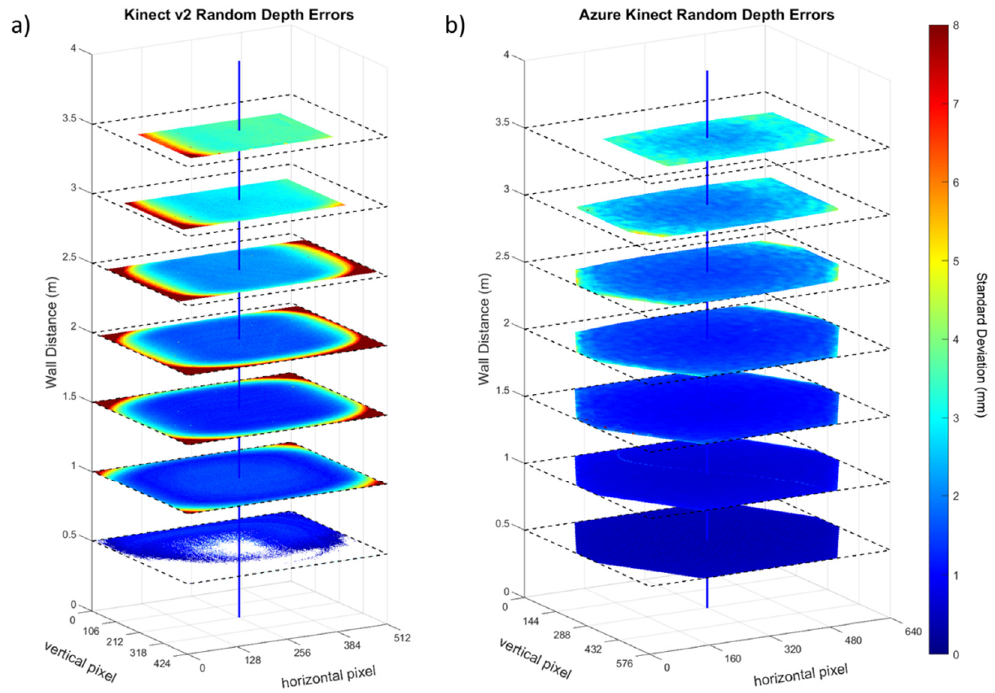
Figure 17. Distribution of the random depth error (mm) at varying distances to a flat wall for the ( a ) Kinect v2 and ( b ) Azure Kinect. The observed flat area was cropped at larger distances to retain the same portion of the scene in all views.